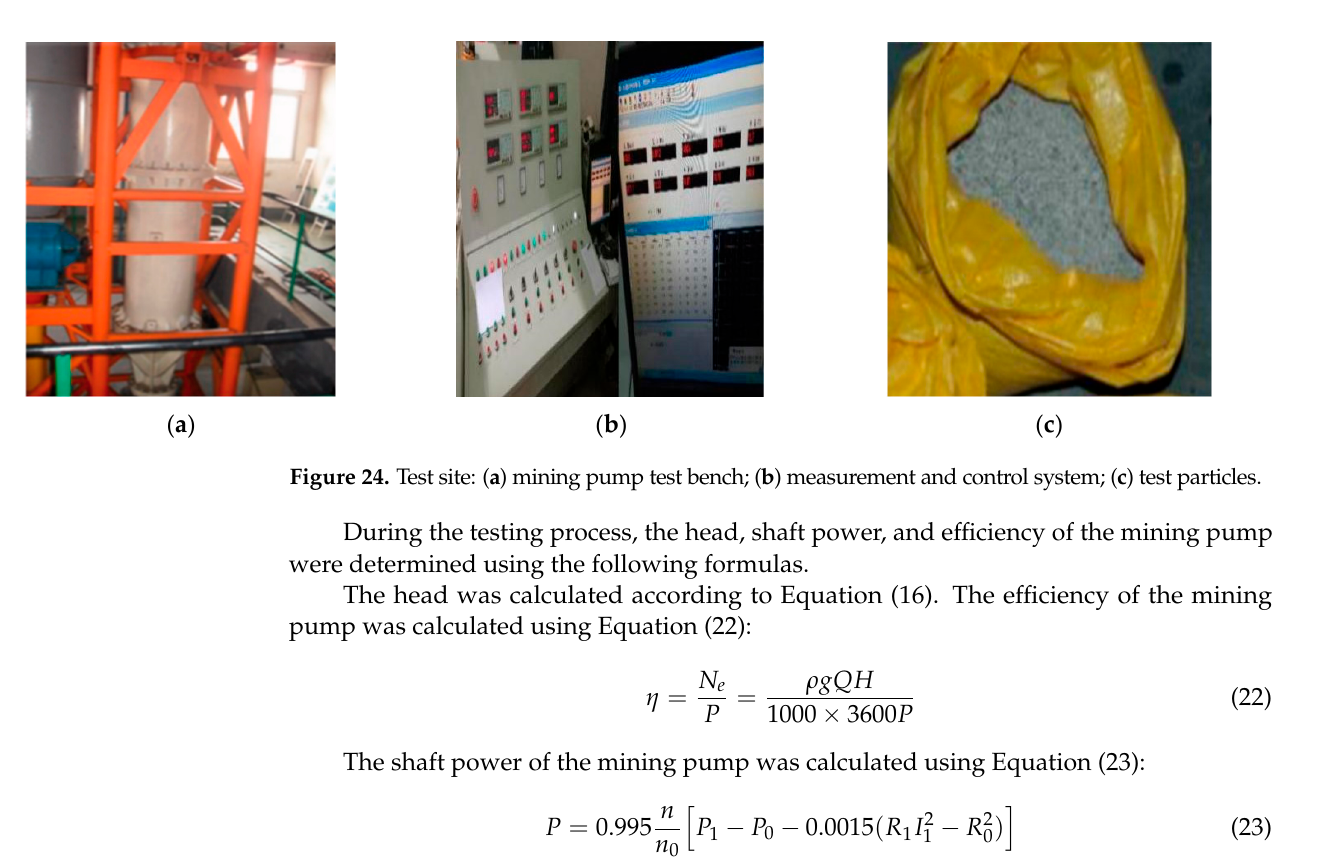
Figure 23. Schematic of the mining pump testing system.